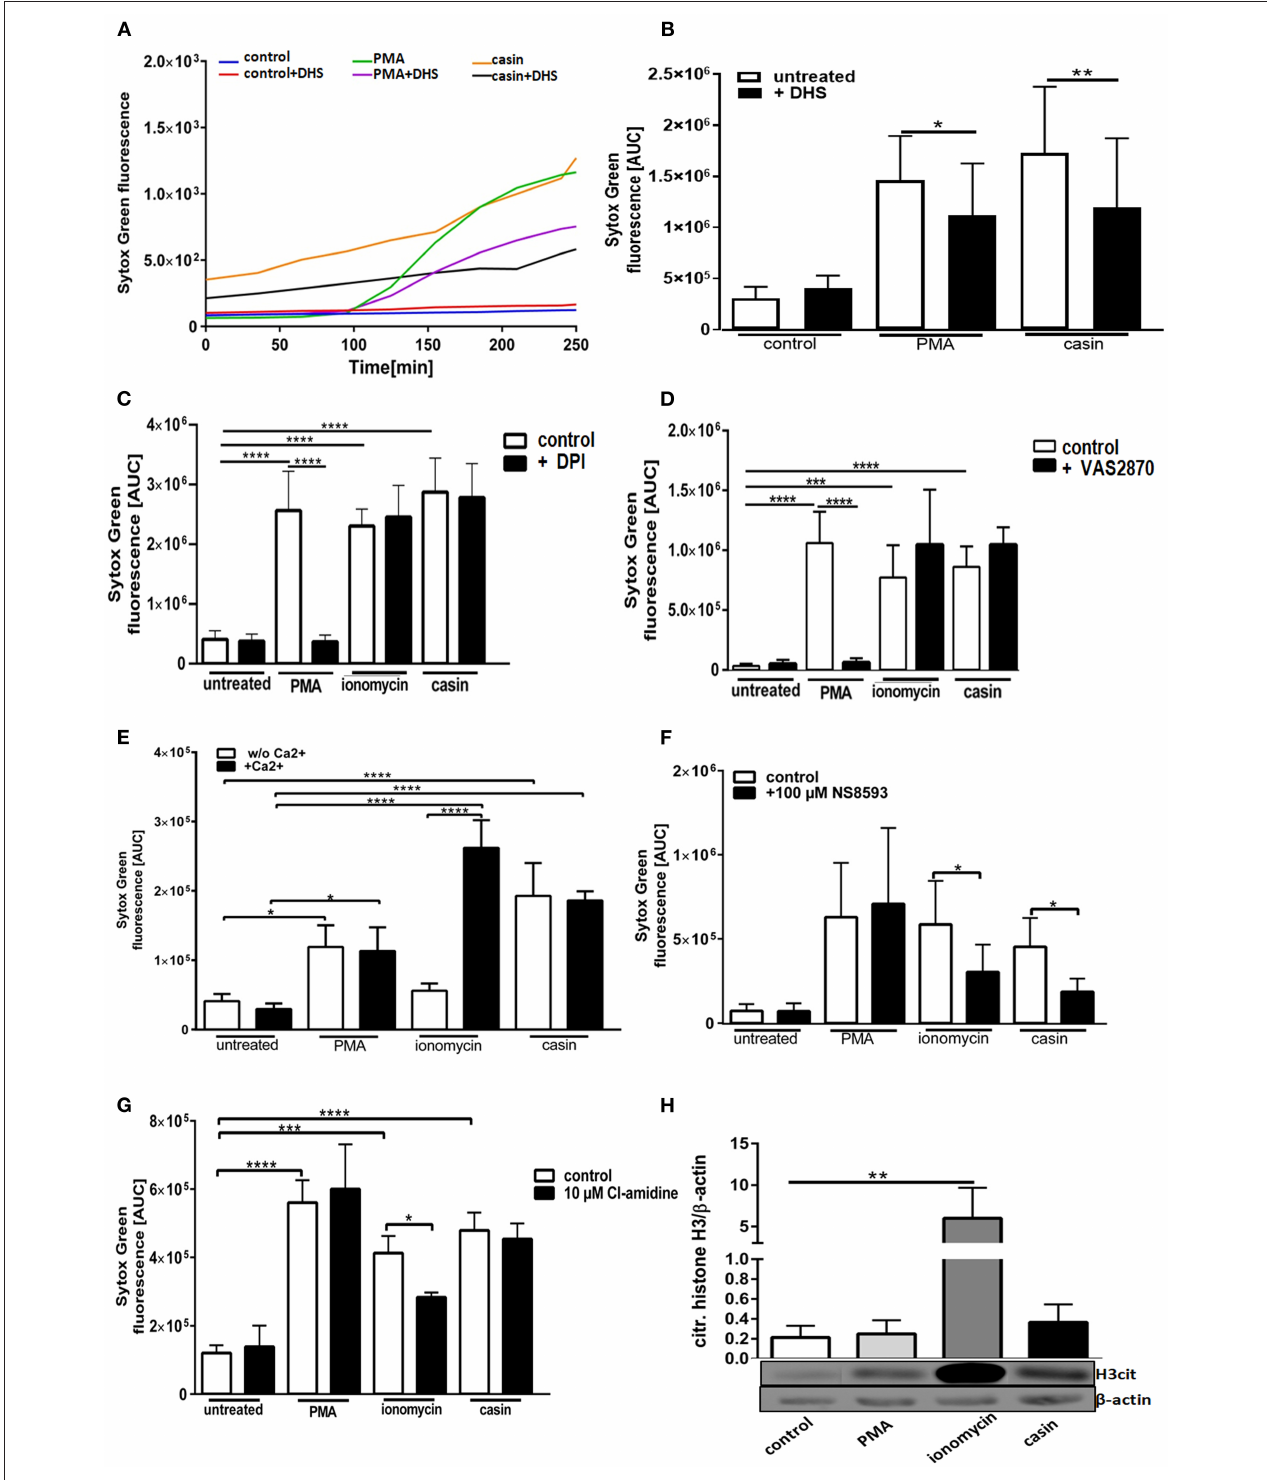
FIGURE 2 | Cdc42 inhibition induces NETs in a Protein Kinase C and SK-channel dependent manner but independent of the NADPH oxidase, extracellular calcium, PAD4, and histone H3 citrullination. Freshly isolated human neutrophils were incubated with or without the Protein Kinase C inhibitor dihydrosphingosine (DHS) (4 µ M) for 30min at 37 ◦ C and subsequently 5 µ M Sytox Green was added to all samples. The formation of NETs without stimulation (control), with 20nM PMA or with the